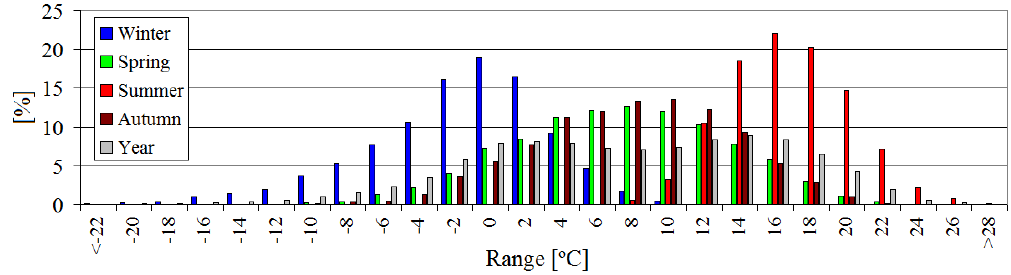
Figure 5. Frequency of occurrence of daily air temperature values (Ta) in 2 °C intervals by seasons and annually for the studied region ( n = 23344), 1951–2014; n-sample size.